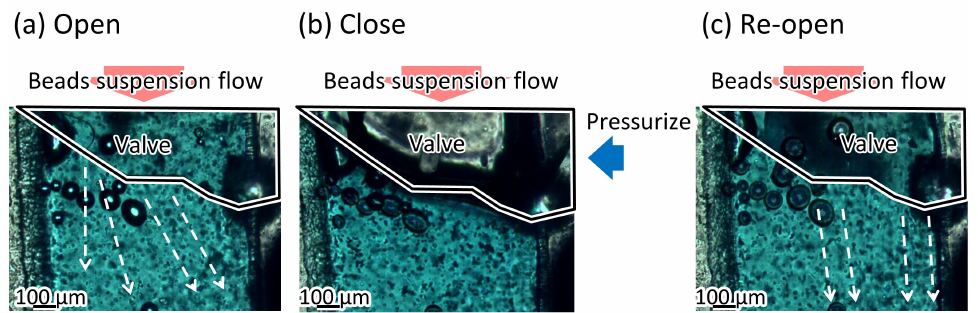
Figure 12. Damming of the beads’ suspension flow using the microvalve. ( a ) Beads in the bead suspension pass through the microvalve when the microvalve is open; ( b ) beads stop when the microvalve is closed; ( c ) beads flow againg when the microvalve is reopened.